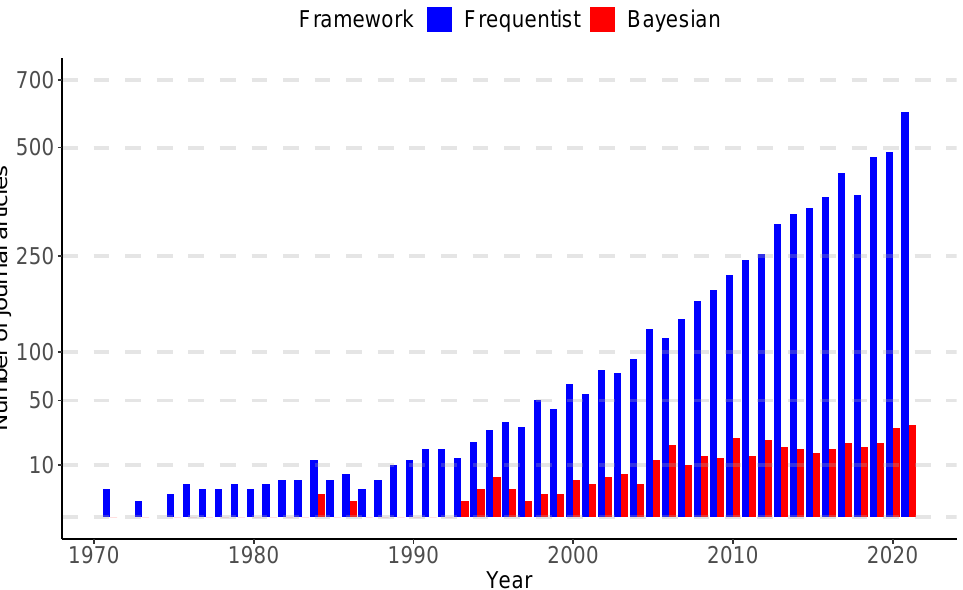
Figure 1. Publication trends of the nonlinear mixed-effect models categorized by frequentist and Bayesian frameworks. the x -axis represents the year from 1 January 1970 to 31 December 2021. The value on the y -axis is the number of published articles in each year (data sources: PubMed.gov, accessed on 23 February